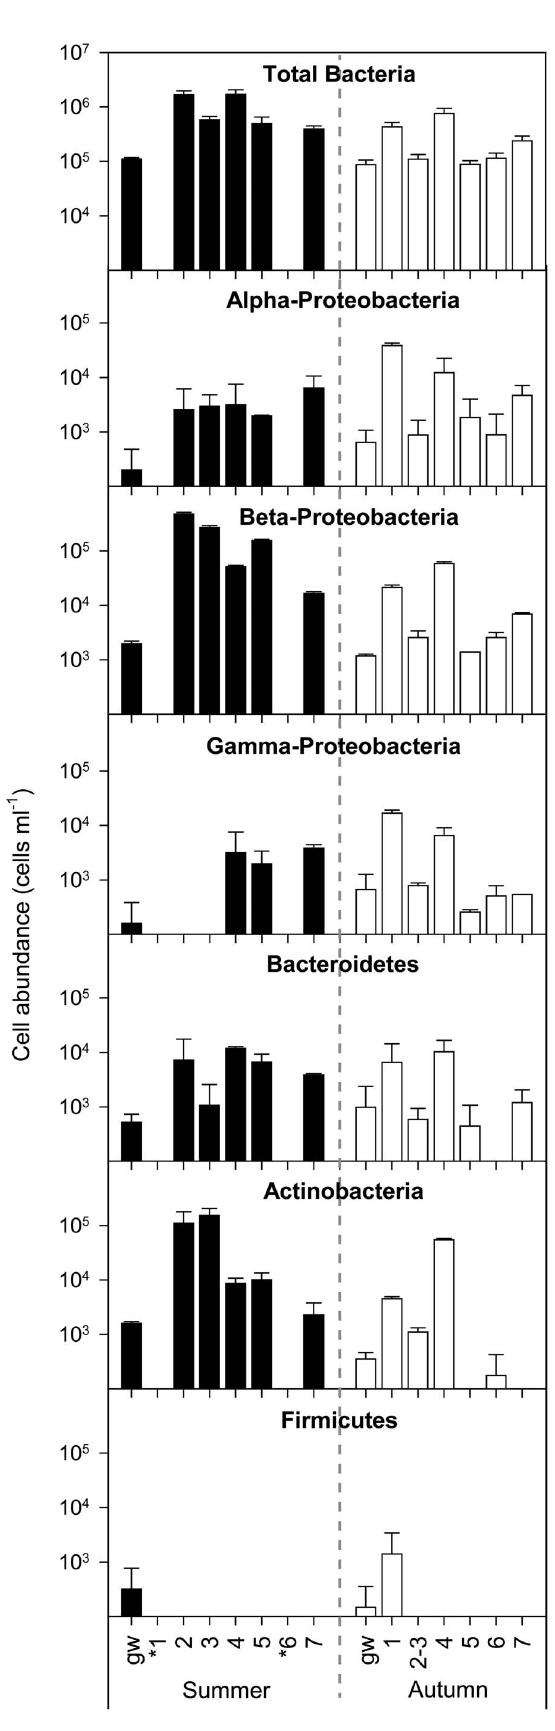
Figure 4. Bacterial abundance. Abundance of the selected bacterial phylogenetic groups as analysed by CARD-FISH. Values are expressed as cells per ml. Error bars indicate standard deviation. (*)=dry reach in